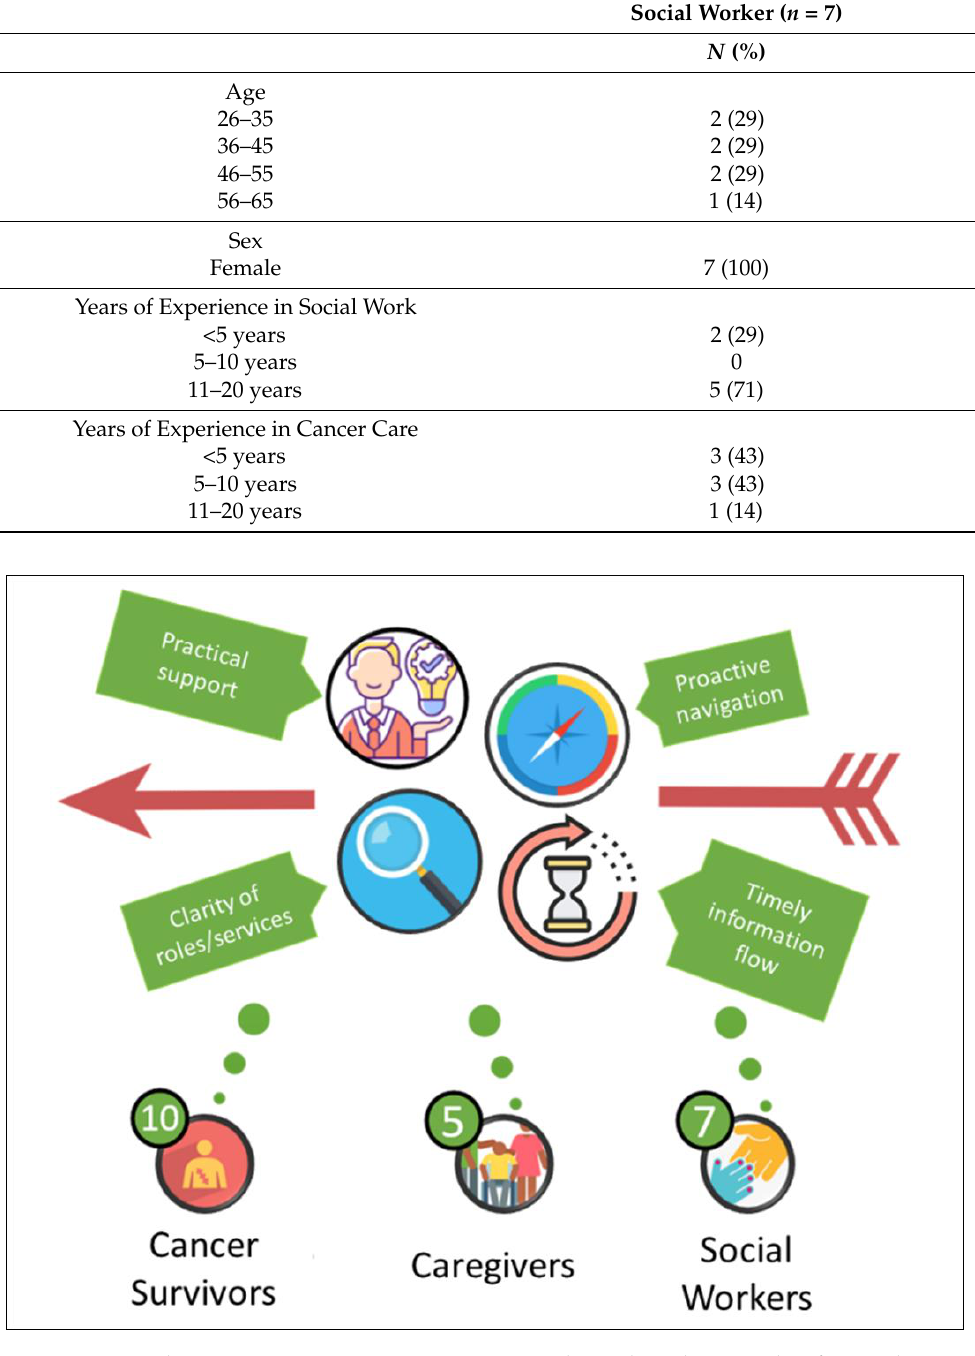
Figure 1. According to cancer survivors, caregivers, and social workers, quality financial toxicity management should include: (i) genuine concern for financial toxicity of cancer survivors and care- givers through practical support by health care providers; (ii) clarity of role and services; (iii) timely information flow; and (iv) proactive financial